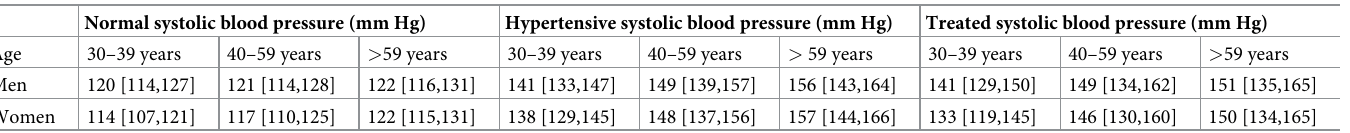
Table 1. Blood pressure distribution according to